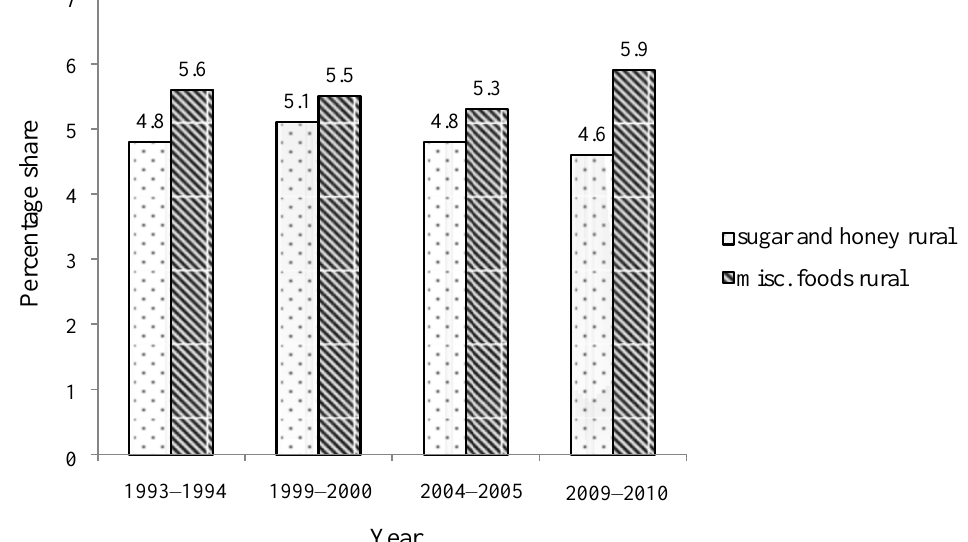
Figure 4. Percent share of total calories from “sugar and honey” and “misc. foods” in rural population of India, 1993–2010.